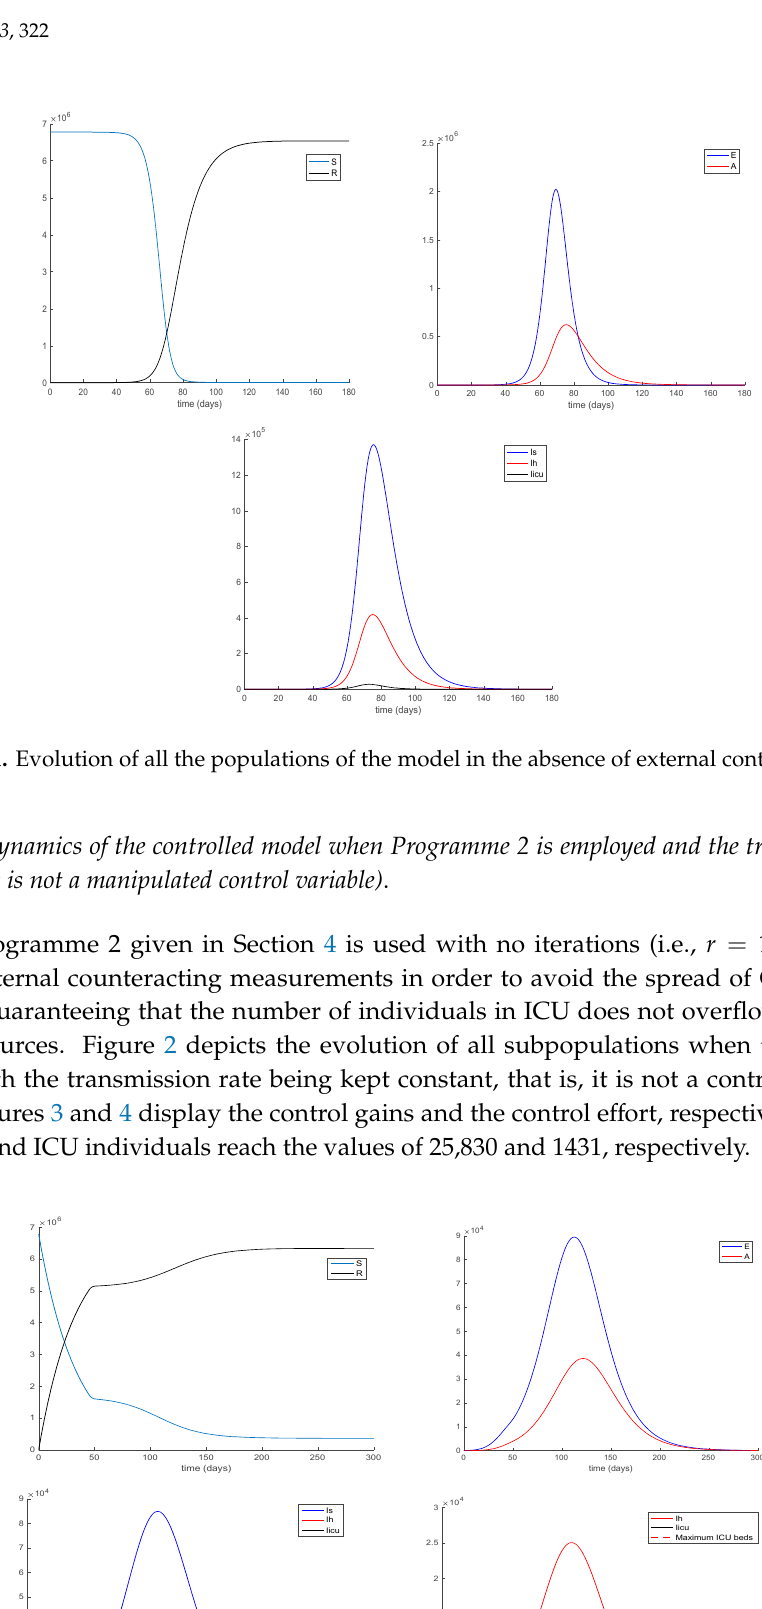
Figure 3. Control gains provided by Programme 2.